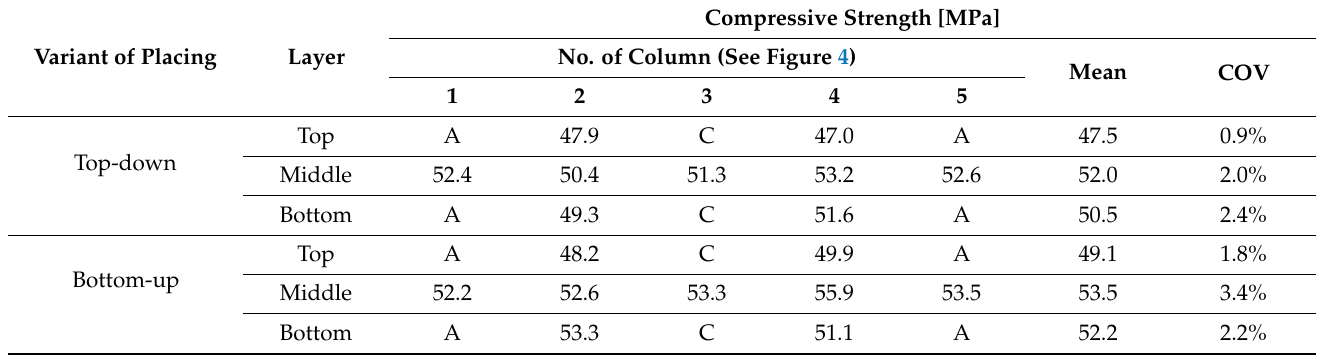
Table 4. Compressive strength test results for cubic specimens.